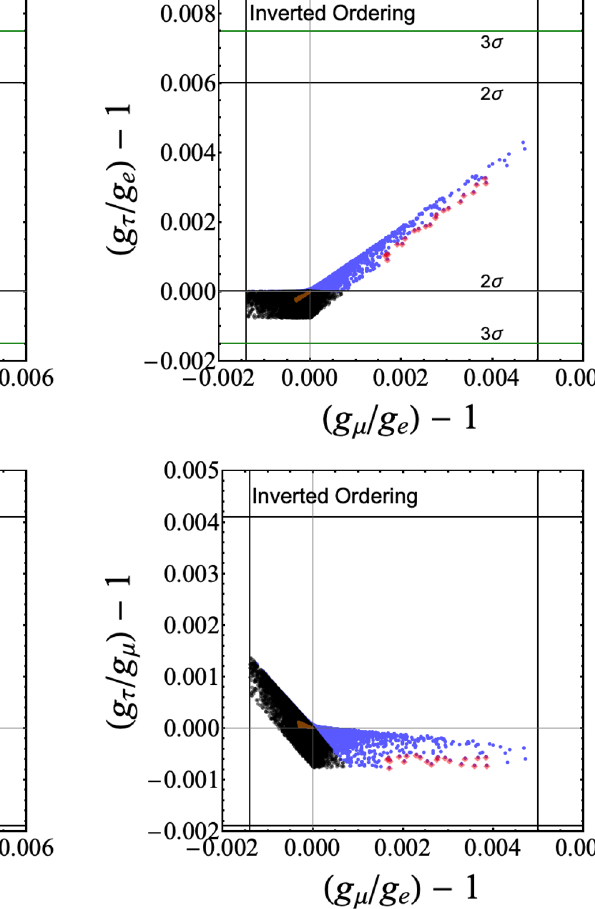
Figure 2 . Correlations among deviations of g µ /g e , g τ /g e (top) and g τ /g µ (bottom) from univer- sality for NO (left) and IO (right). All shown sample points explain neutrino masses and respect the bounds arising from the flavour observables considered in this work. For the blue points, the deviation of g τ /g e from universality is explained at 2 σ in the linear case (Case I), and for the black points at 3 σ , but not at 2 σ . The red diamonds also explain the flavour anomalies, for which g τ /g e must be respected at 2 σ . Brown points pertain to the quadratic case (Case II) which only occurs at 2 σ for NO and at 3 σ for IO. Solid lines indicate current experimental bounds (black for 2 σ or 90 % CL, and green for 3 σ